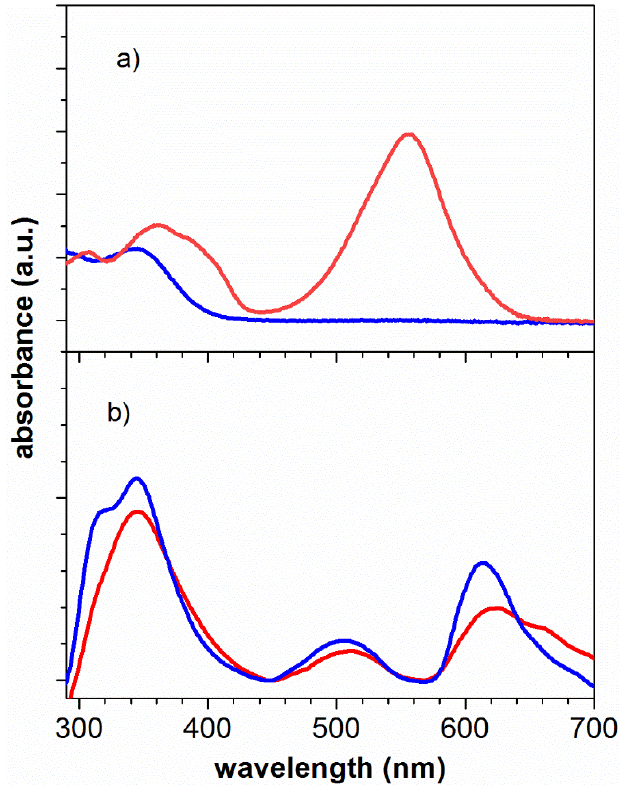
Figure 6. Ultraviolet–visible spectra of an acetonitrile solution of: ( a ) PS- b -PMMA- SP after irradiated (red spectrum) and ( b ) PS- b -PMMA- SP -ZnSNPs at 5 wt.%, after irradiated for 5 min (red spectrum) and 10 min (blue spectrum) with an ultraviolet light lamp at 365 nm (95 mW/cm 2 ).